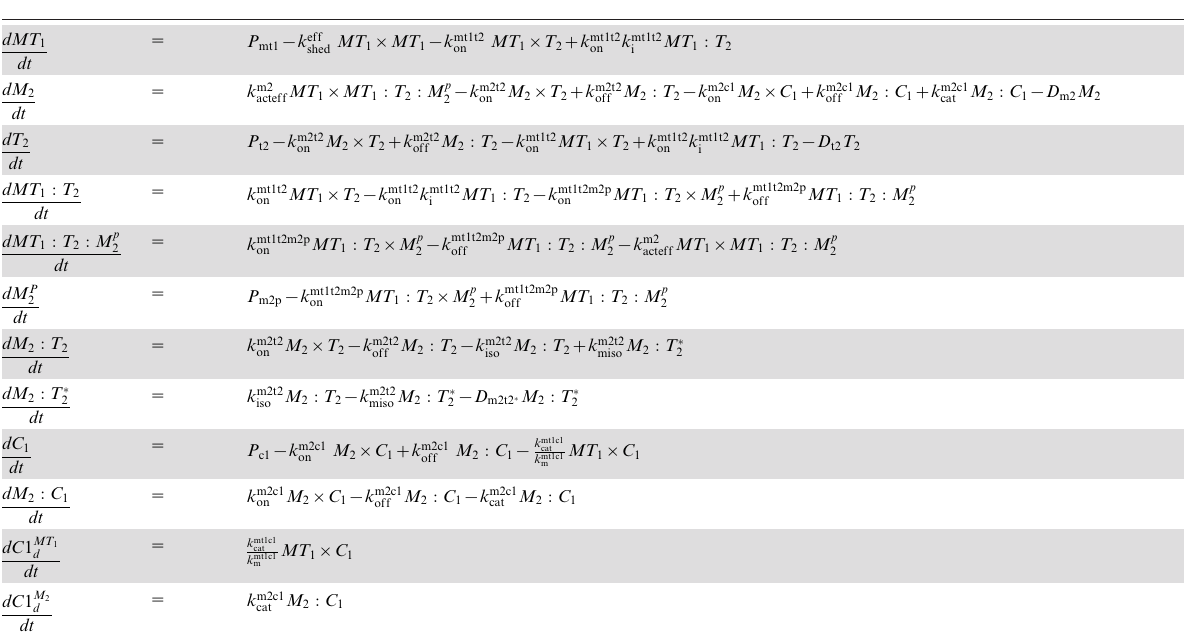
Table 2. The equations for the system.